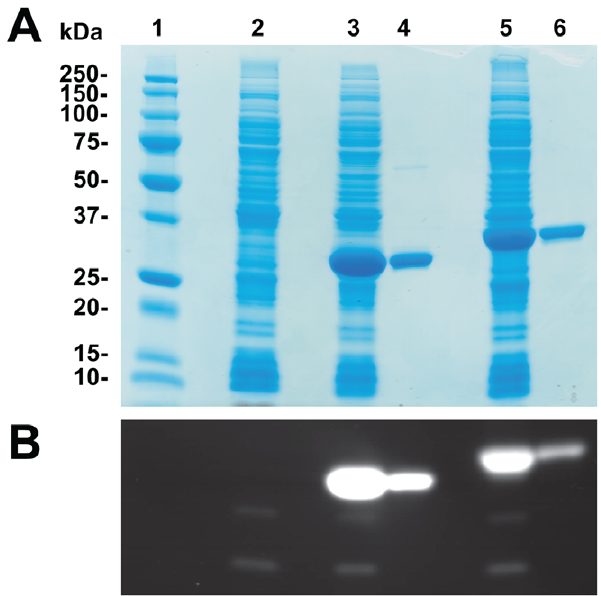
Figure 2. SDS-PAGE and zymogram of purified recombinant proteins. A) SDS-PAGE. Lane 1: Precision Plus All Blue molecular weight standard (Bio-Rad). Lane 2: Soluble fraction of control strain harboring vector pET16b. Lanes 3 and 5: Soluble fractions of E. coli strains harboring pET-EstB and pET-EstC vectors, respectively. Lane 4: Purified EstB after IMAC chromatography. Lane 6: Purified EstC after IMAC chromatography. B) Zymogram. Lane order is identical to panel A. The equivalent of 5 m g of purified enzymes were loaded in lanes 4 and 6.